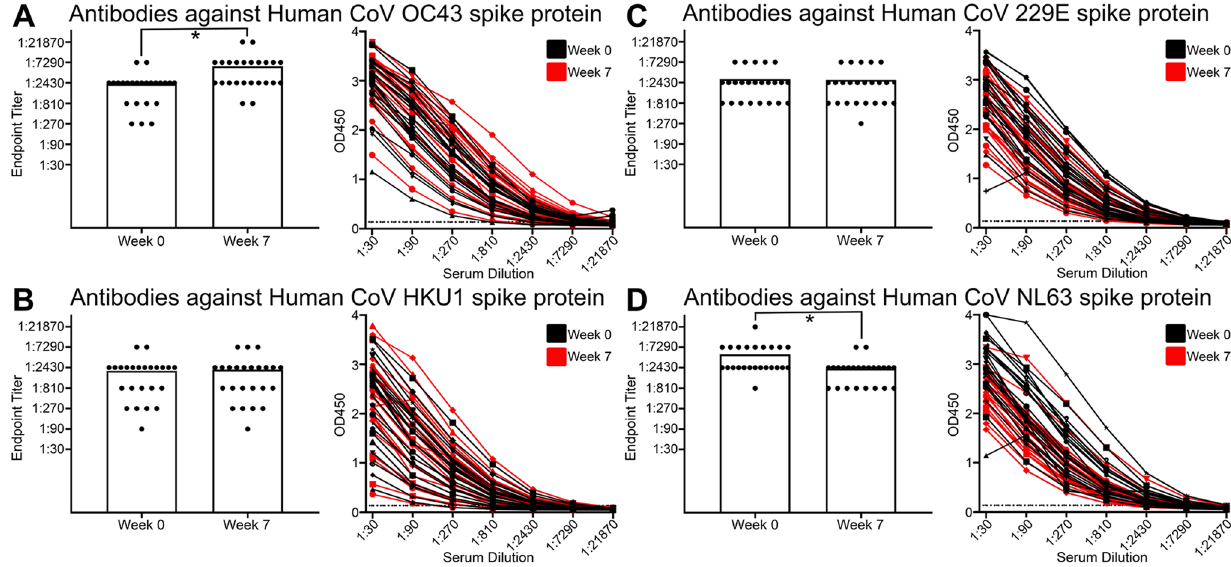
Figure 3. Vaccination targeting SARS-CoV-2 did not significantly affect antibody responses against most seasonal coronaviruses. ( A ) Bar and line graph of antibody responses obtained by ELISA at different plasma dilutions to Human CoV OC43 spike protein, before the Pfizer-BioNTech BNT162b2 vaccine was administered (Week 0) and after both doses (Week 7), using plasma from patients with no history of SARS-CoV-2 infection, n = 24 individuals, p ≤ 0.0001. ( B ) Bar and line graph of antibody responses obtained by ELISA at different plasma dilutions to Human CoV HKU1 spike protein, before the Pfizer-BioNTech BNT162b2 vaccine was administered (Week 0) and after both doses (Week 7), using plasma from patients with no history of SARS- CoV-2 infection, n = 24 individuals, p ≥ 0.99. ( C ) Bar and line graph of antibody responses obtained by ELISA at different plasma dilutions to Human CoV 229E spike protein, before the Pfizer-BioNTech BNT162b2 vaccine was administered (Week 0) and after both doses (Week 7), using plasma from patients with no history of SARS-CoV-2 infection, n = 24 individuals, p = 0.75. ( D ) Bar and line graph of antibody responses obtained by ELISA at different plasma dilutions to Human CoV NL63 spike protein, before the Pfizer-BioNTech BNT162b2 vaccine was administered (Week 0) and after both doses (Week 7), using plasma from patients with no history of SARS-CoV-2 infection, n = 24 individuals, p ≤ 0.0001. Endpoint titers are designated by the most dilute plasma concentration detected above the minimum threshold of the background OD450 multiplied by 3. Dots are representative of individual samples. Bars are representative of the mean of all samples. Statistical analysis was performed using Wilcoxon matched-pairs signed rank test with two-tailed P values